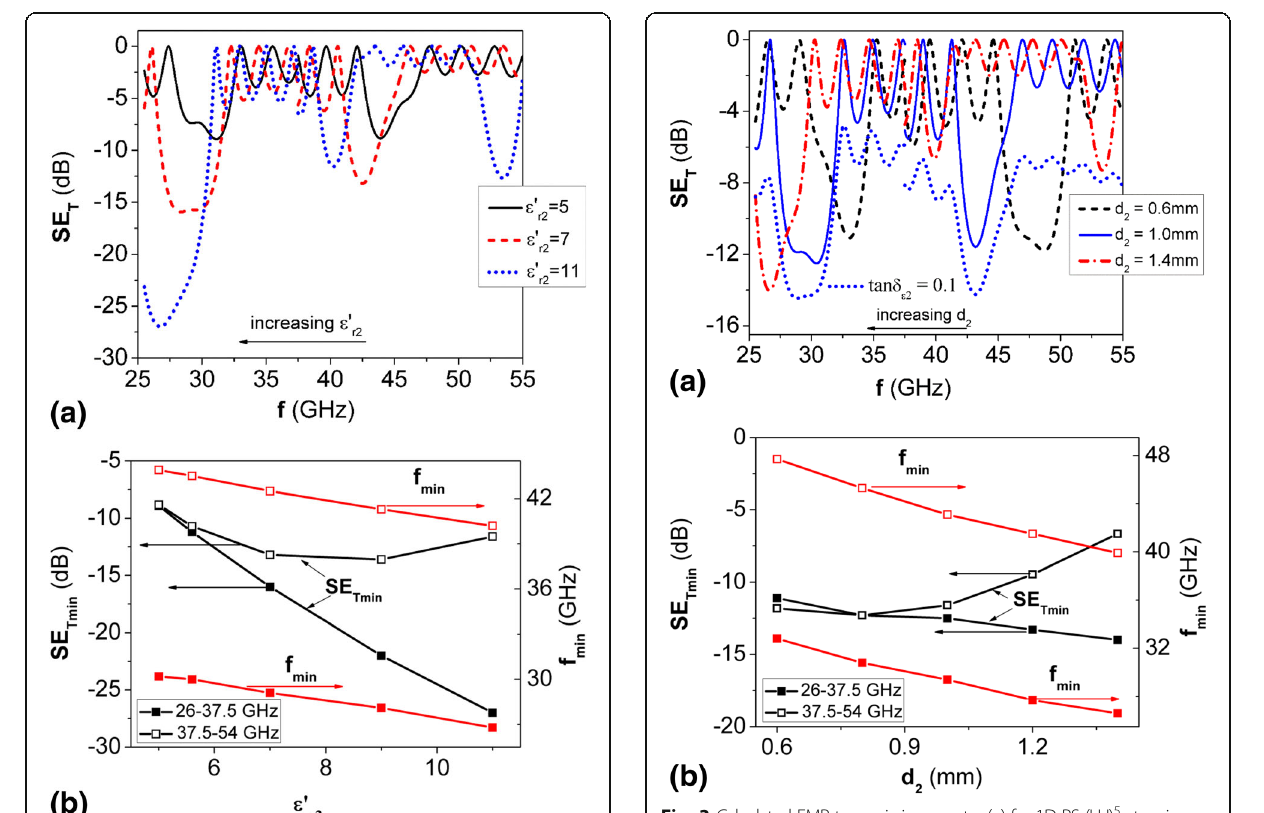
¼ 2 : 9; d ε ′ ¼ 6; r 2 1 = 5mm; 1